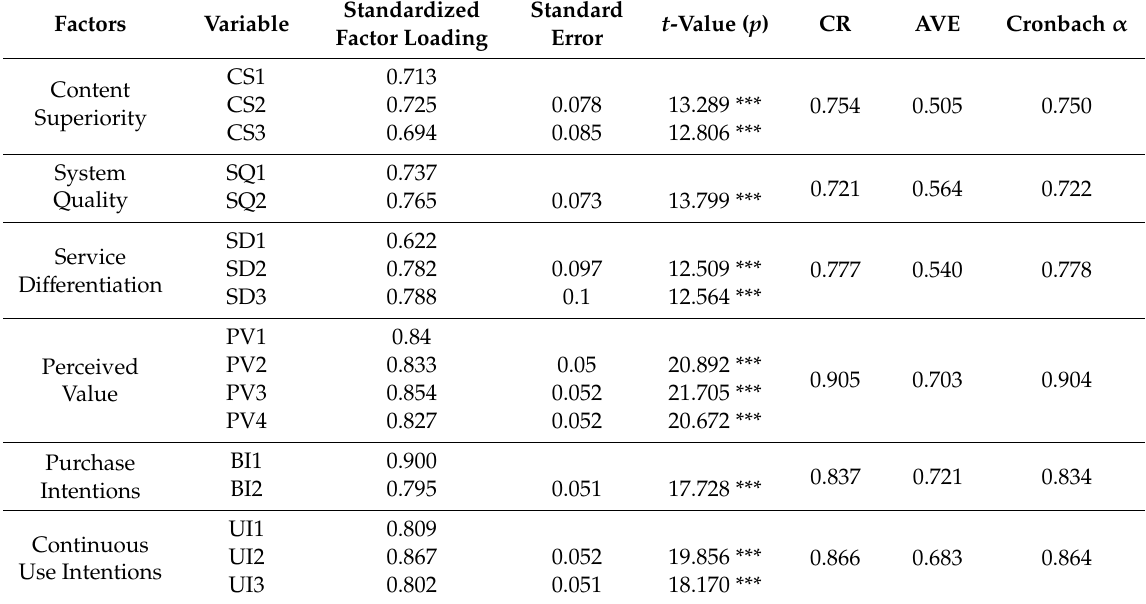
Table 3. Results of reliability and convergent validity testing.